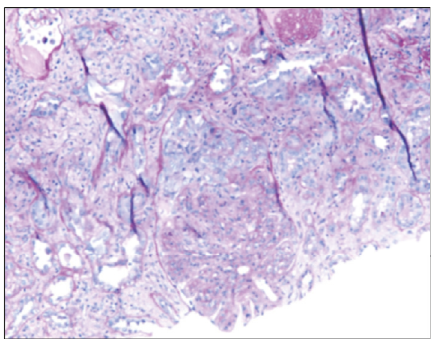
Figure 4: A cellular crescent fills Bowman space adjacent to this glomeruluswithprominentendocapillaryhypercellularity(Periodic